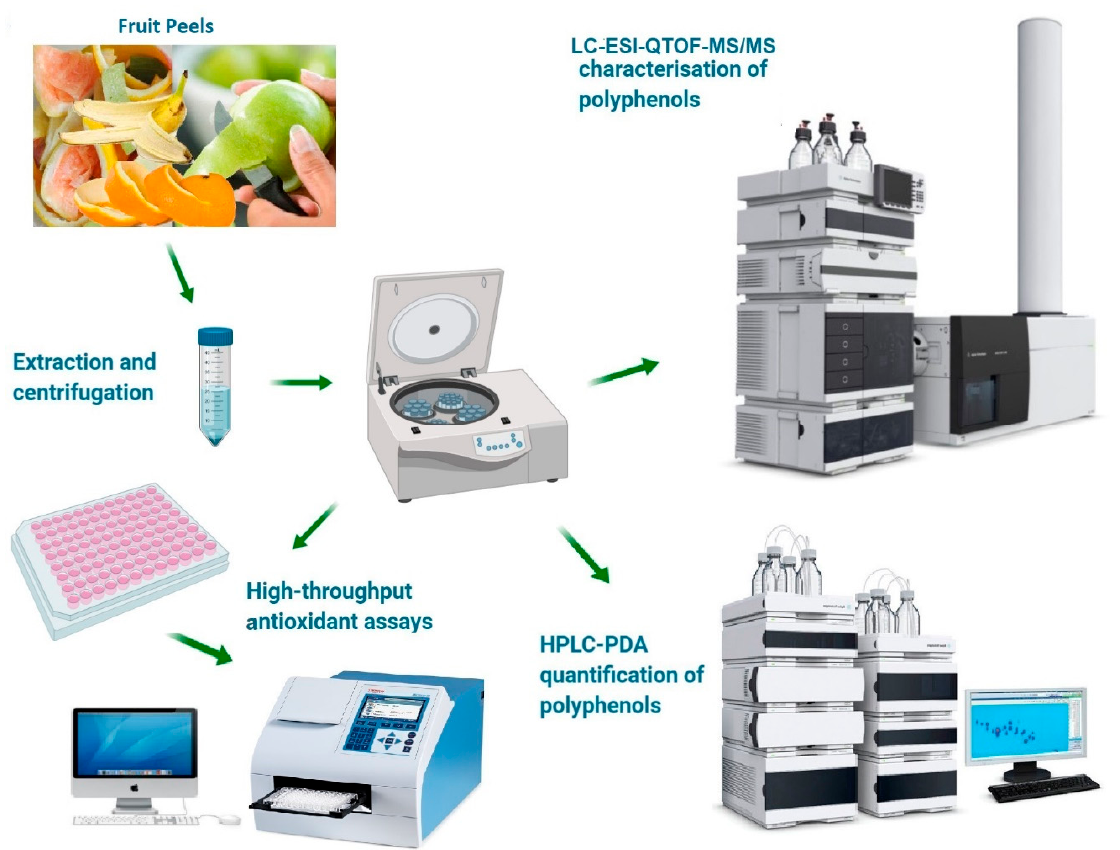
Figure 1. Graphical overview and schematic layout of the proposed research study.